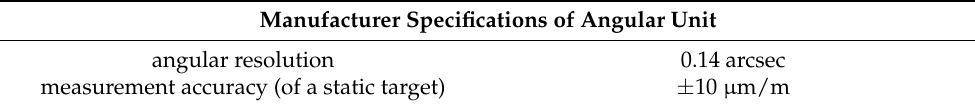
Table 2. The manufacturer specifications of angular unit of laser tracker Leica LTD